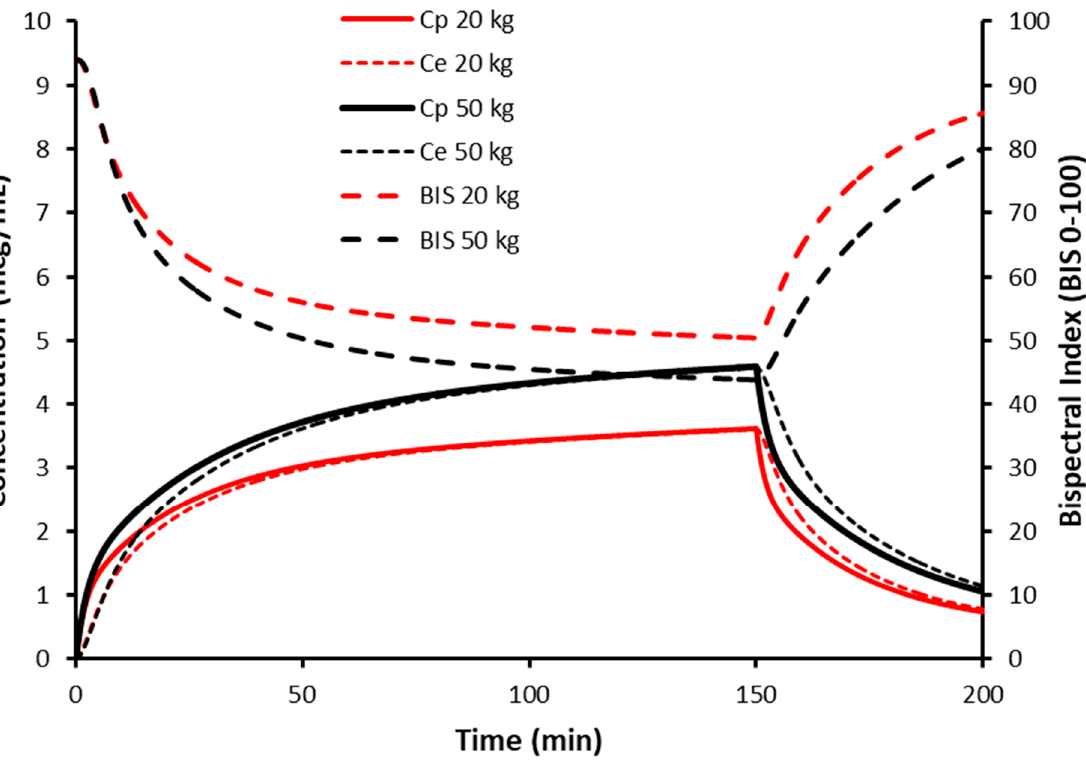
Figure 3. Propofol time concentration and concentration effect profiles after infusion (10 mg/kg/h) in a 6-year-old male child of 20 kg, height 115 cm and a 6-year-old child of 50 kg, height 115 cm. Effect is measured by bispectral index (BIS). Concentrations are higher in the 50 kg child because clearance is less than that in the 20 kg child.